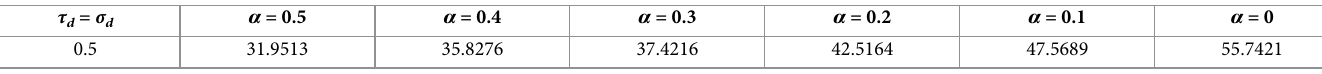
The purpose of example 3 is compare the maximum allowable bounds for tolerable delays of σ ( t ) which ensure the exponential stability with the fuzzy convergent rate α of the T-S fuzzy dynamic Table 2. The maximum allowable bounds of σ 2 with Example